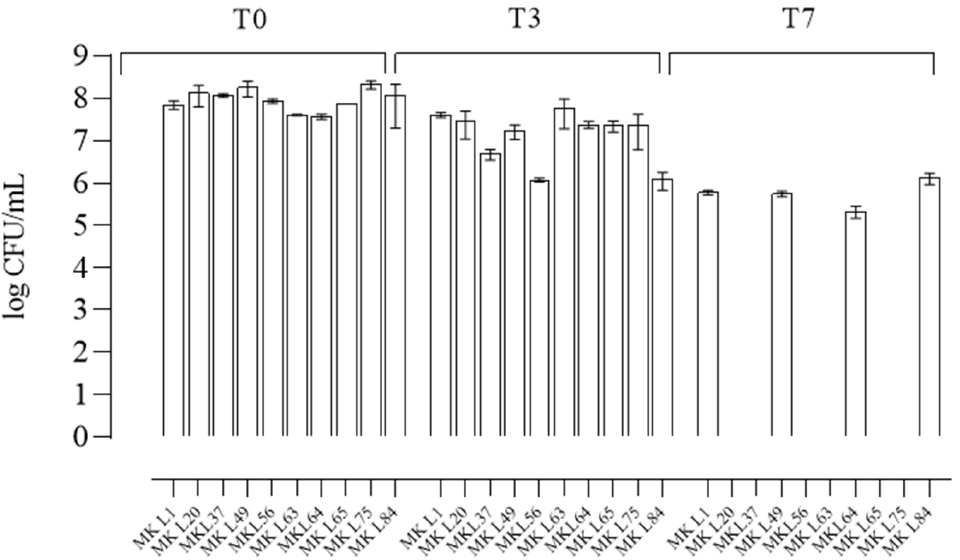
Figure 5. Survival (mean ± standard deviation, n = 3) of lactic acid bacteria strains during exposition to simulated gastrointestinal conditions for 3 h (T3, end of the gastric phase) and 4 h (T7, end of the enteric phase).